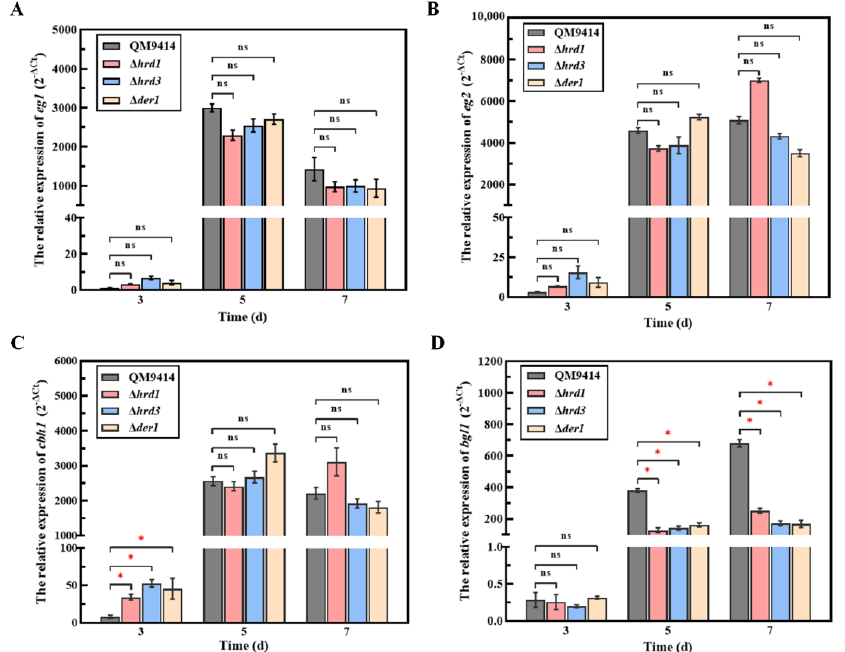
Figure 6. The transcription levels of cellulase component genes in ERAD-deficient mutants under cellulase-induced secretion conditions. ( A ) The relative transcription level of endoglucanase Ⅰ gene eg1 in the ERAD-deficient mutants under cellulase-induced secretion conditions. ( B ) The relative transcription level of endoglucanase Ⅱ gene eg2 in the ERAD-deficient mutants under cellulase-induced secretion conditions. ( C ) The relative transcription level of cellobiohydrolase Ⅰ gene cbh1 in the ERAD-deficient mutants under cellulase-induced secretion conditions. ( D ) The relative transcription level of β -glucosidase gene bgl1 in the ERAD-deficient mutants under cellulase-induced secretion conditions. Cellulase induction medium contained 2% microcrystalline cellulose and 2% corn steep liquor, which promoted the production of large amounts of cellulase. The relative transcription level of each gene was calculated by the qPCR results of the fermentation samples on the 3rd, 5th, and 7th days. Actin gene was universally used to normalize gene transcription levels. Values represent the mean of three repeated measurements taken from at least three parallel experiments. The error bars refer to the standard deviations. The difference between the parental strain and the knockout strains was shown by analysis of ANOVA followed by Tukey’s test. * p < 0.05. ns, not significant.